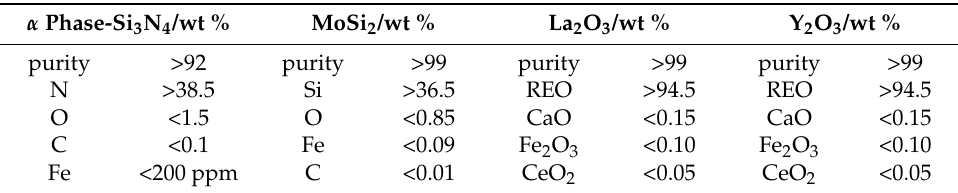
Figure 1. The SEM morphologies of the original powders. ( a ) α -Si 3 N 4 ; ( b ) MoSi 2 ; ( c ) Y 2 O 3 ; ( d ) La 2 O 3 . Table 1. Chemical contents of the original